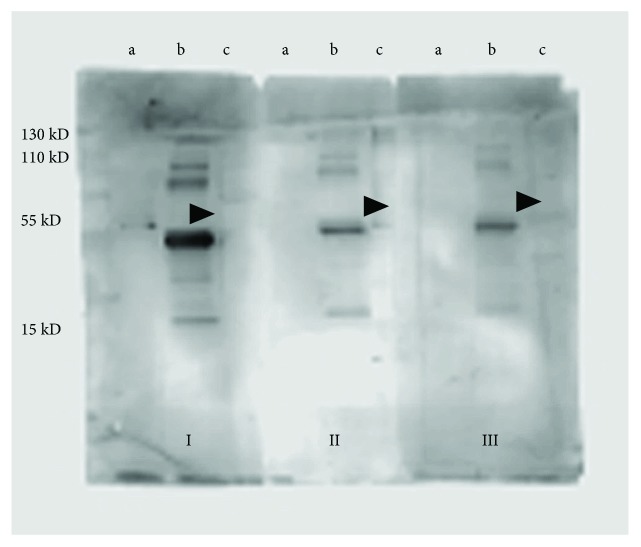
Representative Western blot of human pituitary extracts. Serum samples from patients 16 and 20 (I, II) and healthy subjects (III) were tested on recombinant gamma enolase (a), protein lysates from human pituitary (b), and HEK-293 cells (c). Arrowheads indicate a nonspecific protein band of about 55 kDa which was seen on all lanes with human pituitary's protein lysates, from both patients and healthy subjects. MW: molecular weight marker.